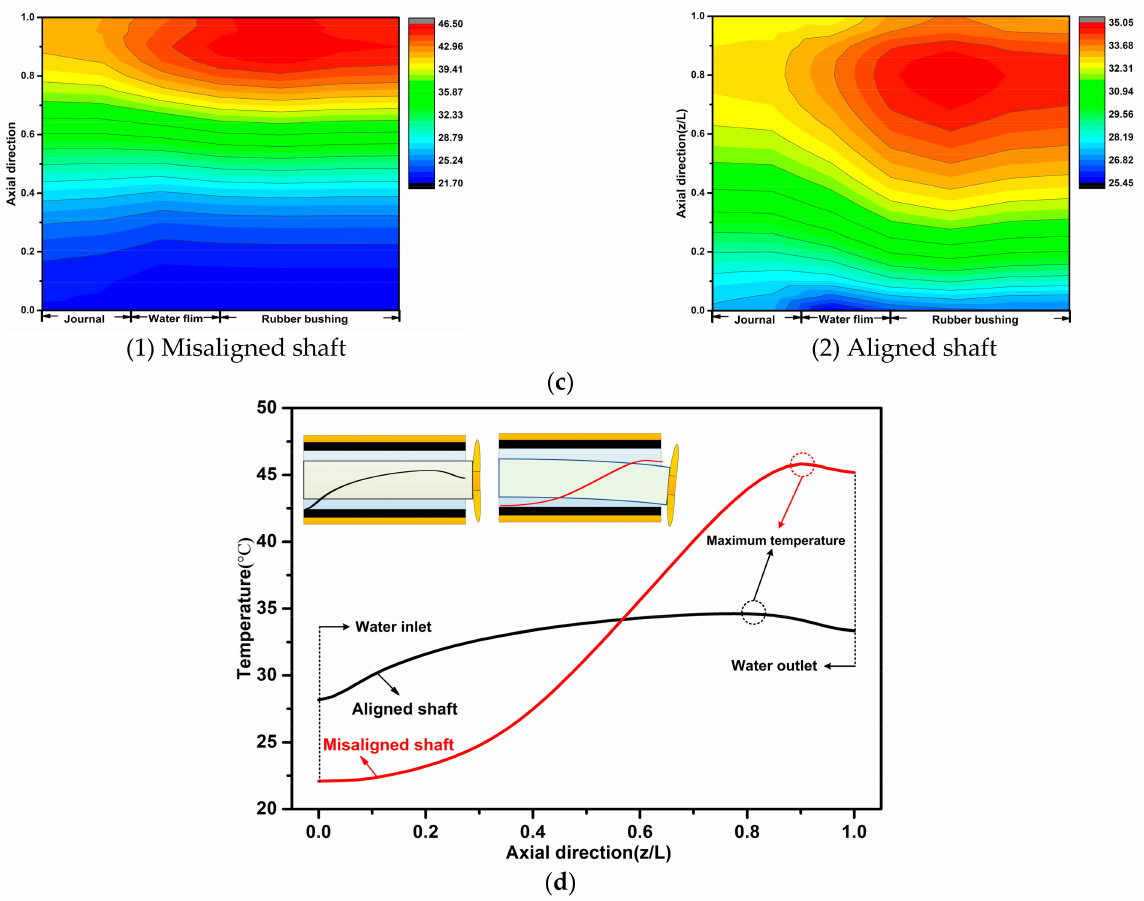
Figure 11. Comparisons of the thermal distribution in the circumferential section, axial direction, and radial section obtained with a misaligned shaft and an aligned shaft: ( a – c ) are the temperature distribution in the circumferential section, axial section, and radial section, respectively: ( d ) is the temperature distribution at the maximum water temperature section in the axial